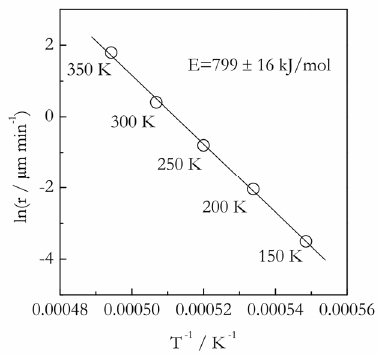
Figure 7. Arrhenius plot for the rate (r) of quartz melting (data from Ainslie et al. [65]). Numbers by the points represent the value of superheating at given temperature. The solid line is a fit to the Arrhenius equation with the activation energy 799 ± 16 kJ ∙ mol − 1 .